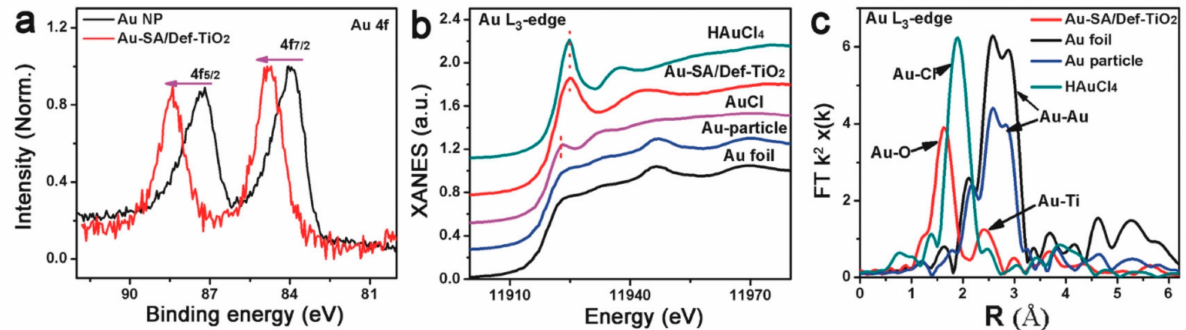
Figure 7. XPS and EXAFS analysis of Au-SA/Def-TiO 2 : ( a ) Au 4f XPS spectra of Au-SA/Def-TiO 2 . ( b ) XANES spectra. ( c ) Fourier transform (FT) of the Au L 3 -edge. Adopted with permission from Ref.